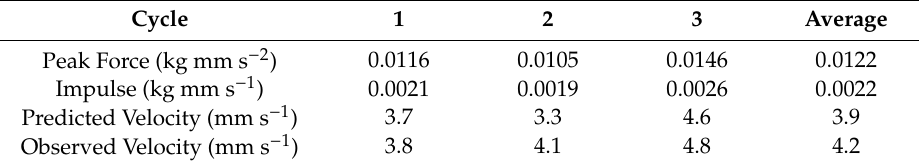
Table 1. Comparison of predicted and observed average velocity values during bell pulsation cycles 1–3. The time interval for each cycle was 0.18 s, and the mass of the medusa was estimated as a sphere of the medusa’s bell diameter (1 cm) having a density equivalent to seawater (1.04 g cm − 3 ). Cycle 1